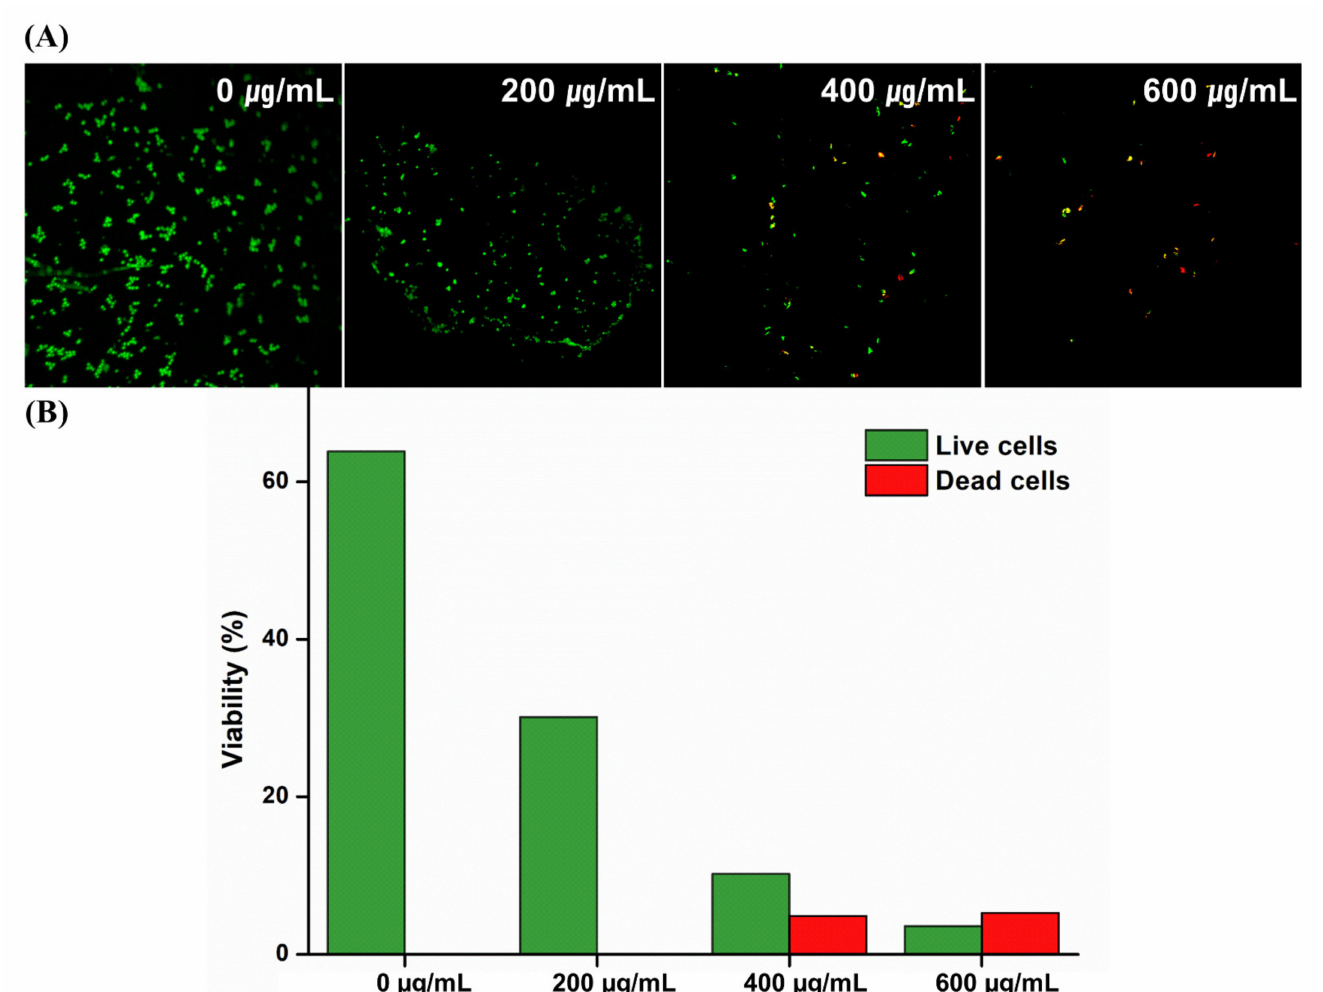
Figure 5. ( A ) Representative microscopic images of the C. albicans adhered on the surfaces of the denture-lining material: 0, 200, 400, and 600 µ g/mL at a magnification of 5000 × , ( B ) quantified fungal viability results of the live and dead cells in equivalent surface